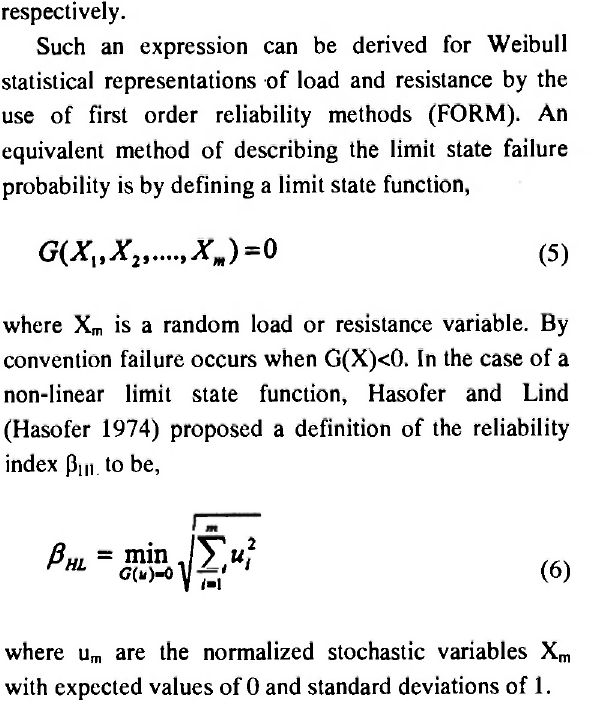
Fig. 3: Proposed simulation for the assessment of acceptable φ